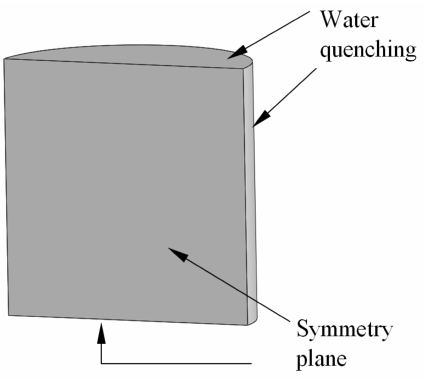
Figure 11. Detail of the FE mesh.